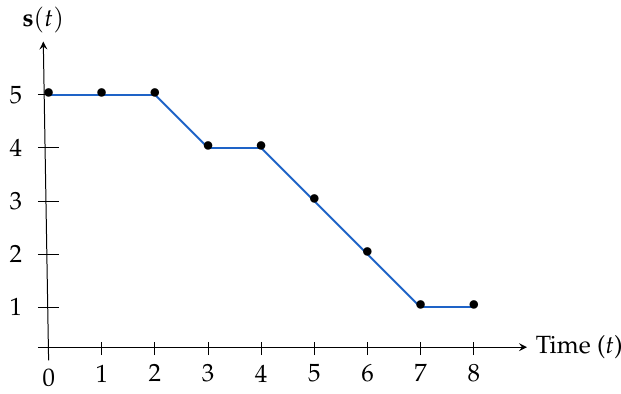
Figure 2. Example of scores describing the freshness of food decreasing over